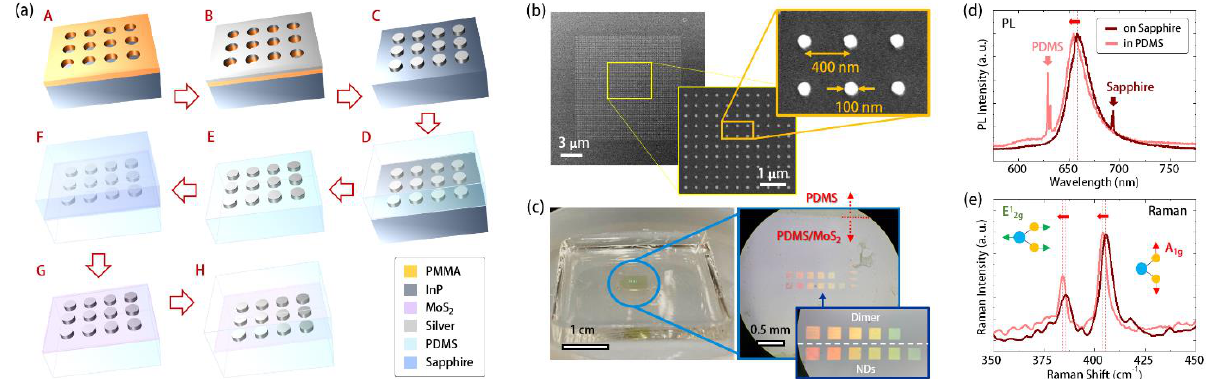
Figure 2. ( a ) Fabrication flowchart of the silver ND array covered by MoS 2 monolayer in PDMS; ( b ) The top-view SEM images in different magnifications of silver ND array on InP substrate in Status C in ( a ); ( c ) picture and OM images of silver ND and ND-dimer arrays with covered MoS 2 monolayer in a PDMS substrate; the measured ( d ) PL and ( e ) Raman spectra of MoS 2 monolayer grown on sapphire and embedded in PDMS. The peaks on both sides of the MoS 2 PL signal in ( d ) correspond to the emissions from PDMS and sapphire substrates.